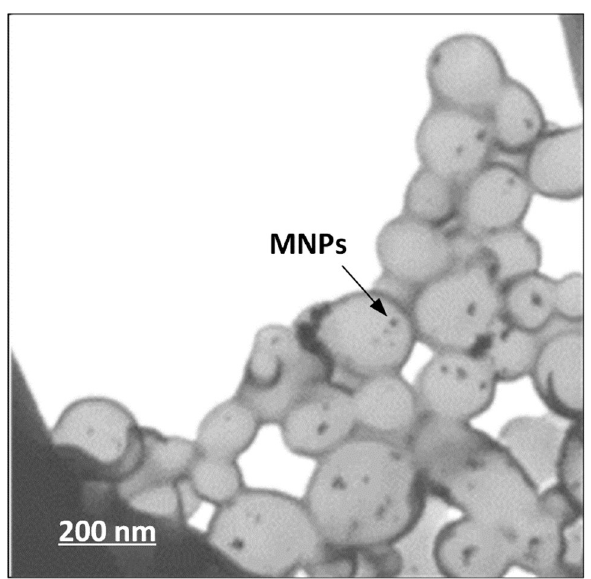
Figure 8. BF-STEM images of the drug-loaded polymeric MnFe 2 O 4 nanoparticles.